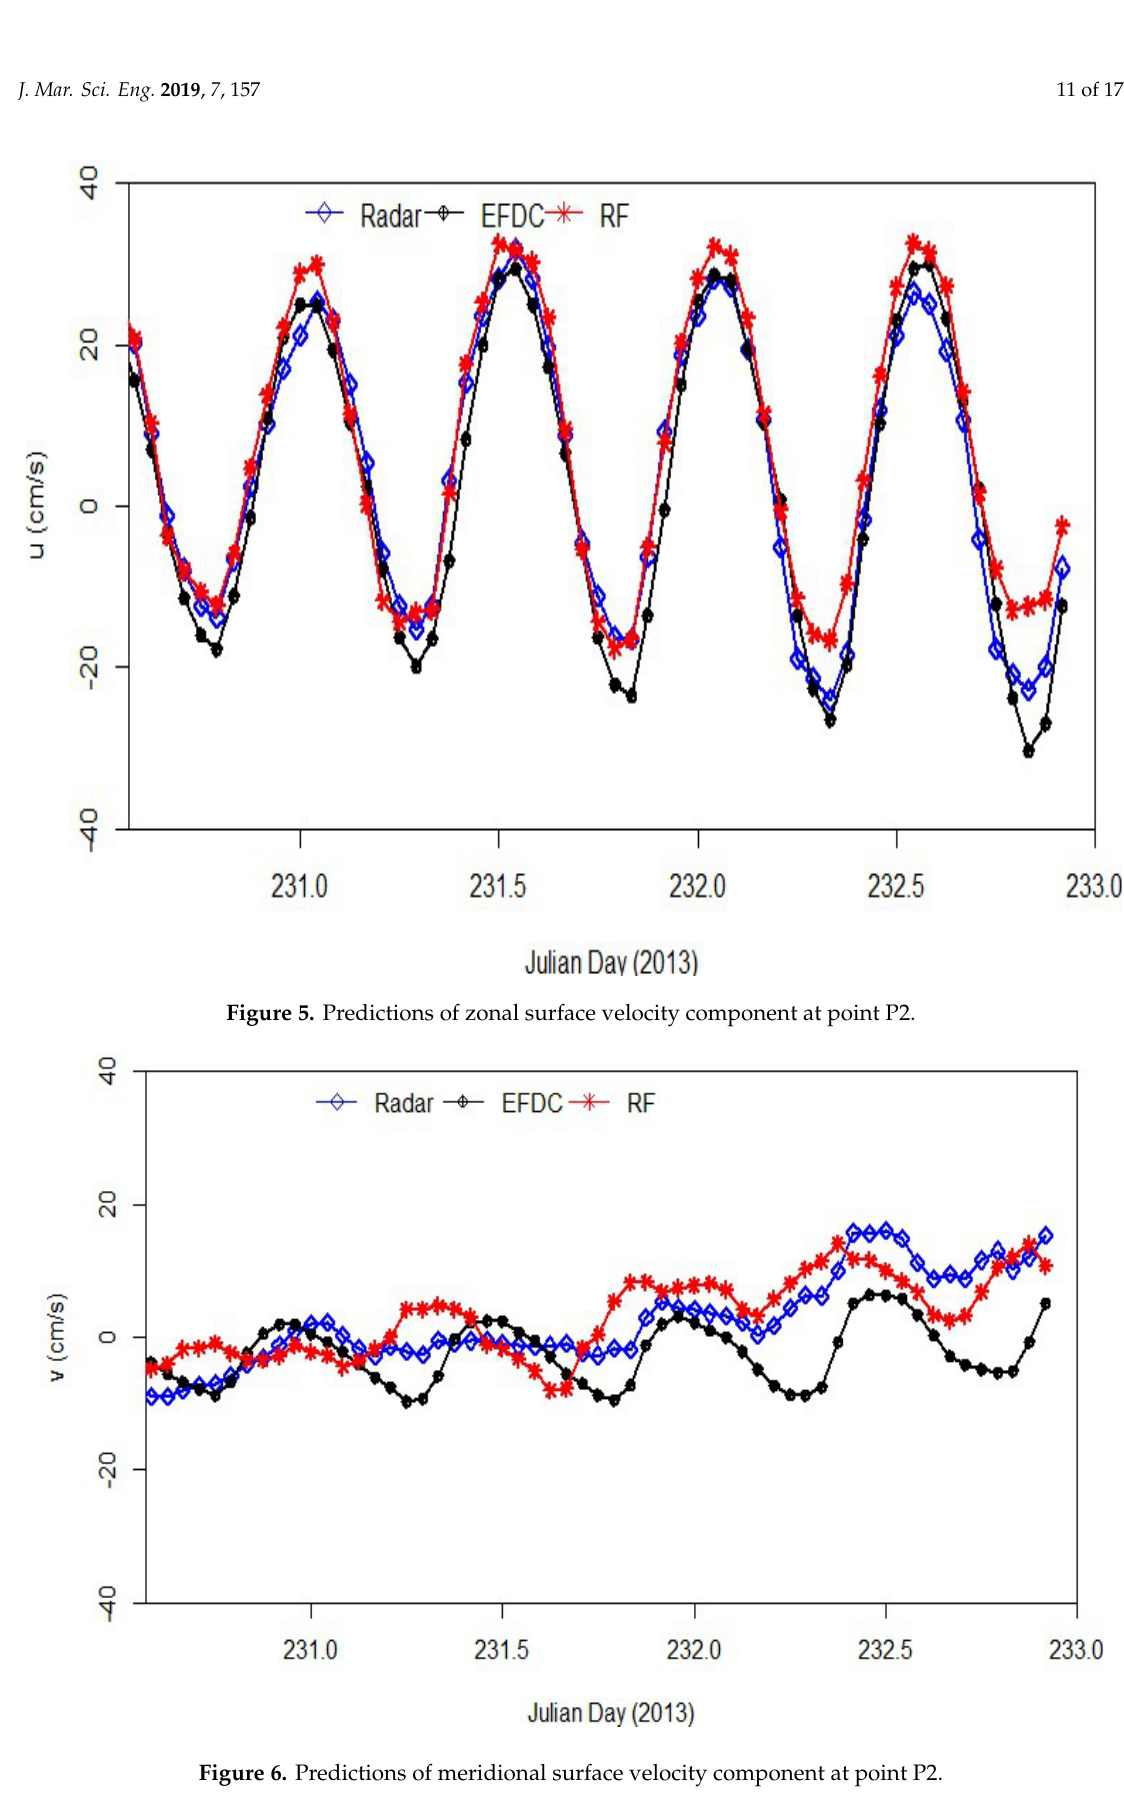
Figure 6. Predictions of meridional surface velocity component at point P2.